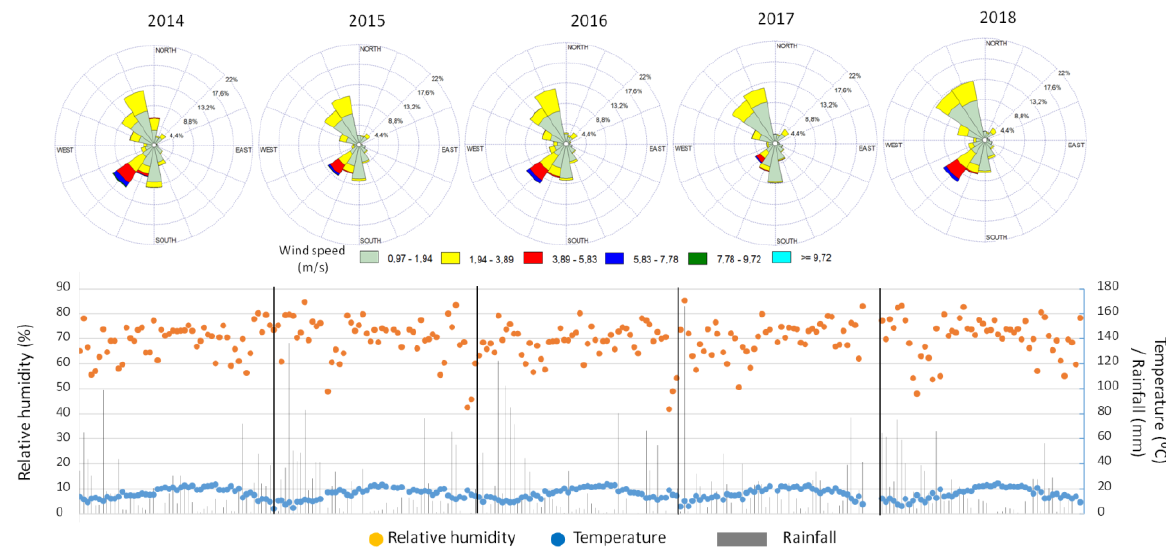
Figure 2. Meteorological measurements during the period 2014–2018 in